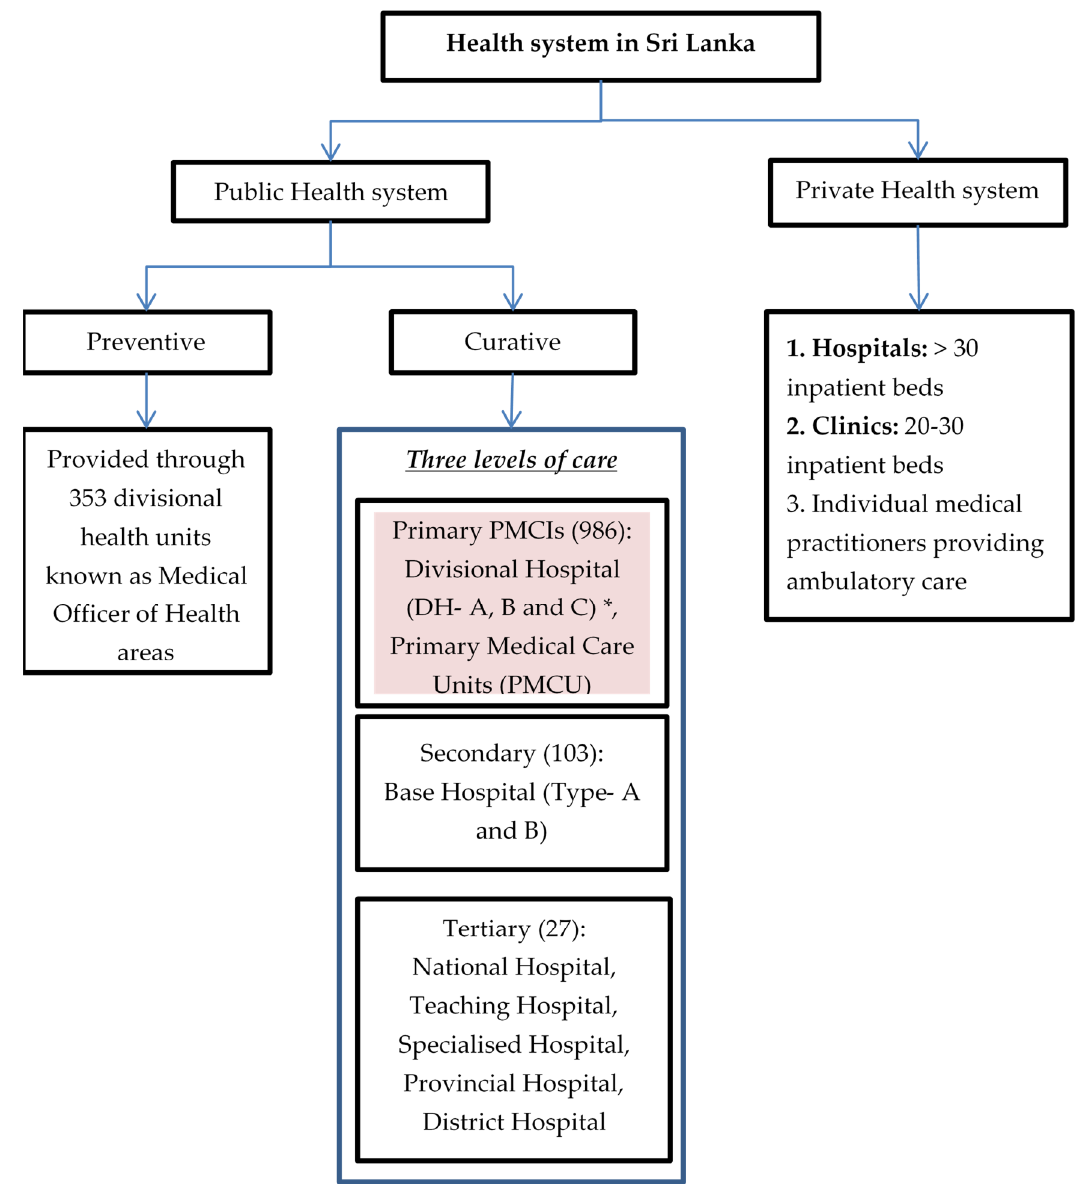
Figure 1. Health system in Sri Lanka, 2021. * DH-A has >100 inpatient beds, DH-B has 50–100 inpatient beds and DH-C has <50